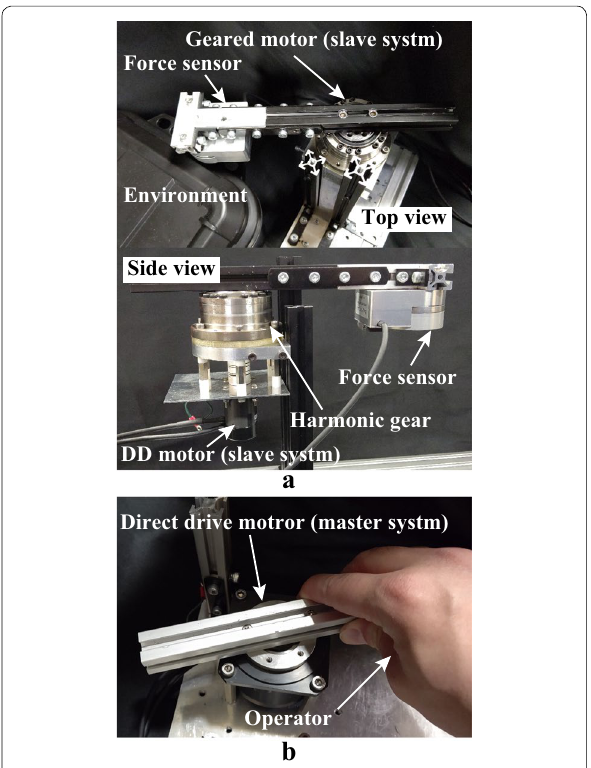
Fig. 14 Experimental setup. a Geared motor (slave system). b Direct drive motor (master